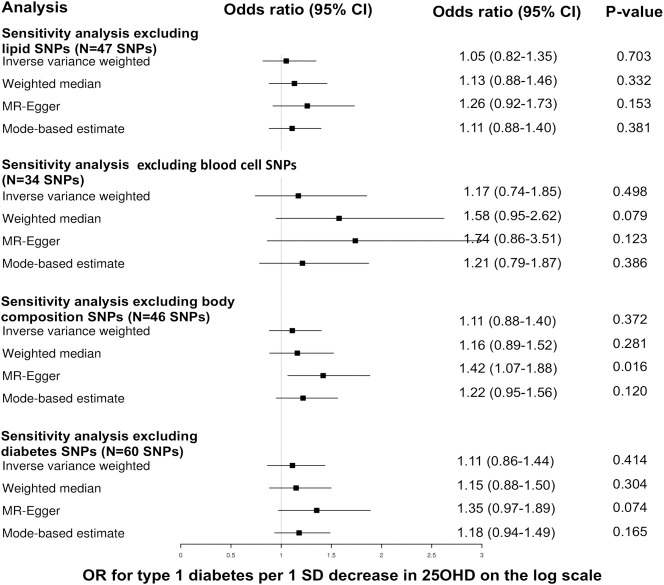
Forest plot of the MR sensitivity analyses excluding SNPs with possible pleiotropic effects.The odds ratios for type 1 diabetes are reported for a 1 standard deviation decrease in 25OHD on the log scale. 25OHD, 25-hydroxyvitamin D; CI, confidence intervals; MR, Mendelian randomization; OR, odds ratio; SNP, single nucleotide polymorphism.